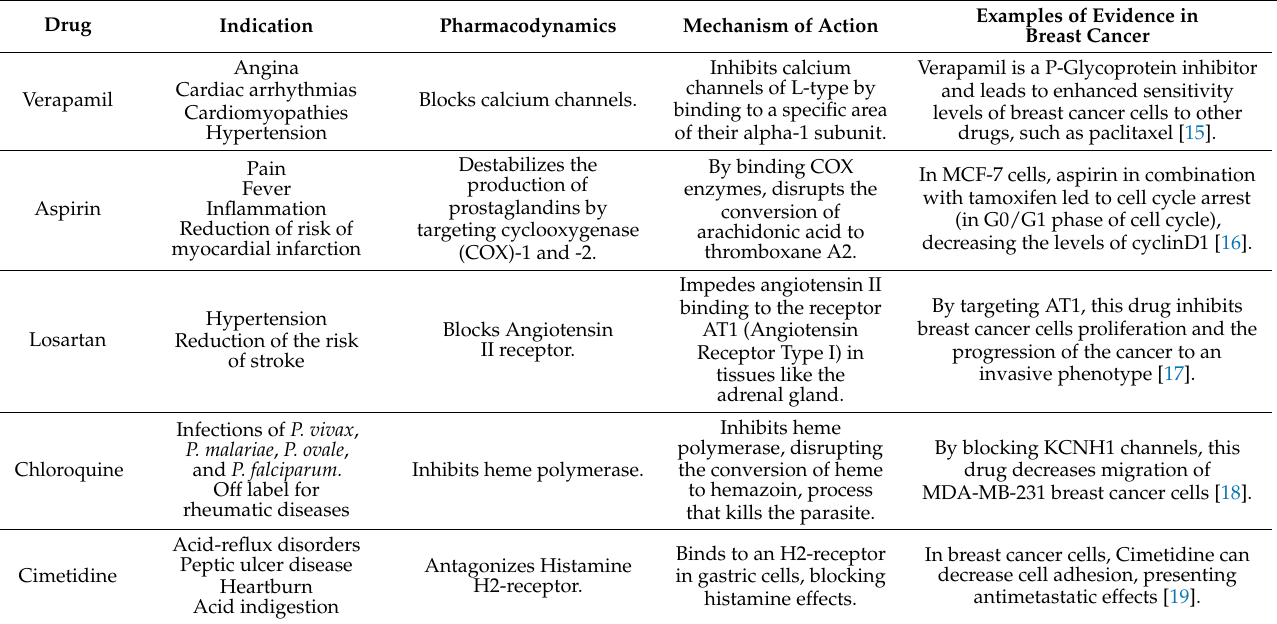
Table 1. Repurposed drugs used in this project, as well as their major clinical indication, pharmacodynamics, and mechanism of action [14]. Some examples of studies in breast cancer with these drugs are also